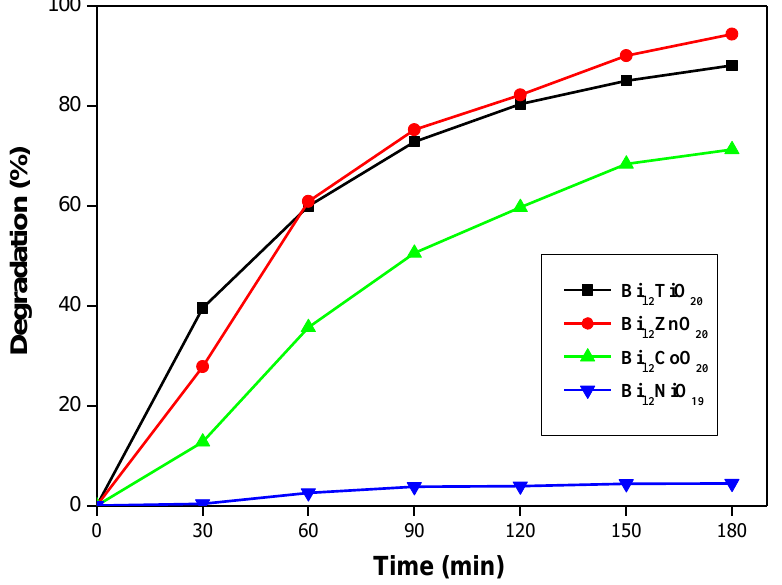
Figure 3. CFX degradation using different sillenite photocatalysts. C CFX = 10 mg/L, pH ~ 6, T = 25 ◦ C and dose of catalyst = 1 g/L.